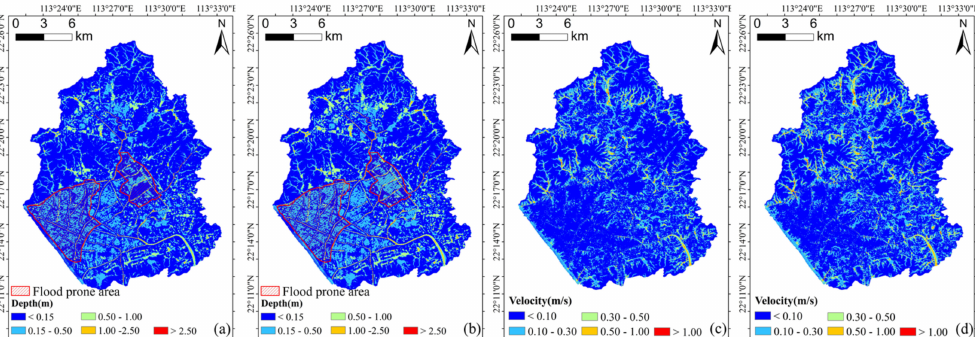
Figure 5. Spatial distribution of inundation depth and velocity. ( a , c ) represent inundation depth and flow velocity for 50-year return period; ( b , d ) represent inundation depth and flow velocity for 100-year return period.